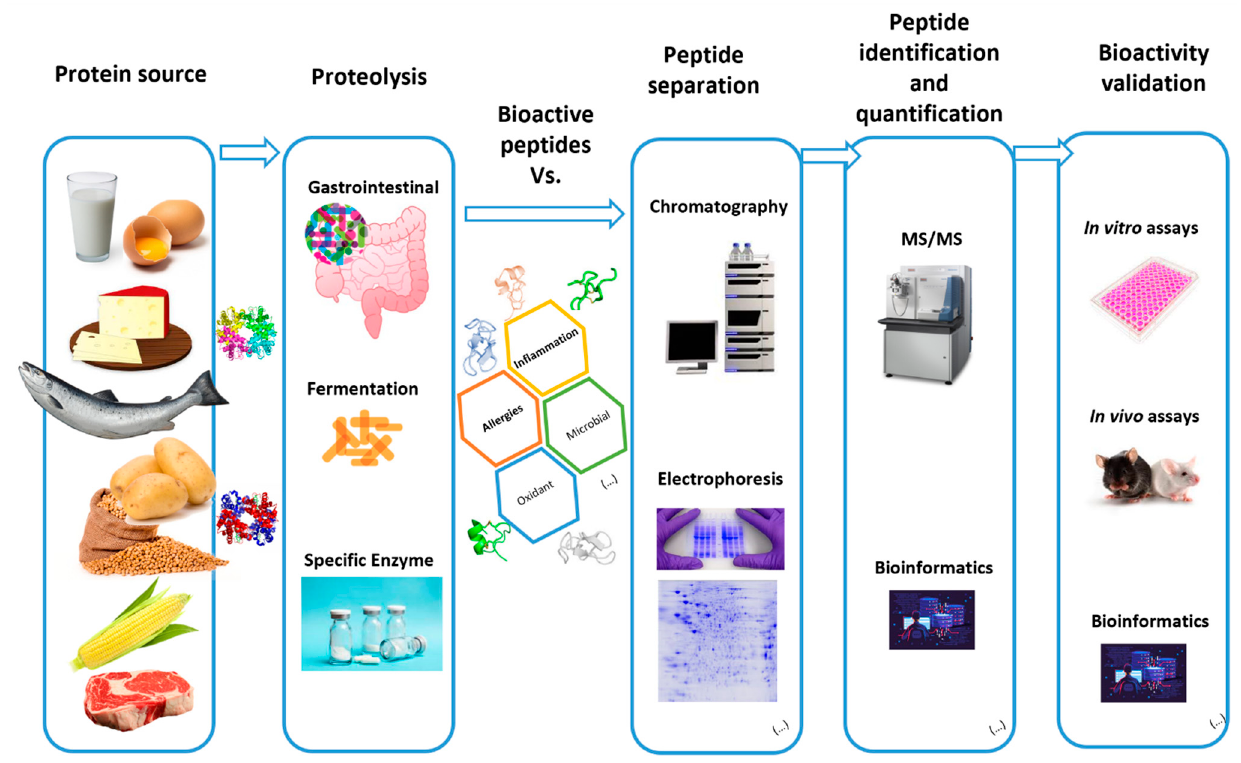
Figure 2. General schematic diagram of bioactive peptide production from foodstuffs and the sequential methods and analysis for its identification and characterization.